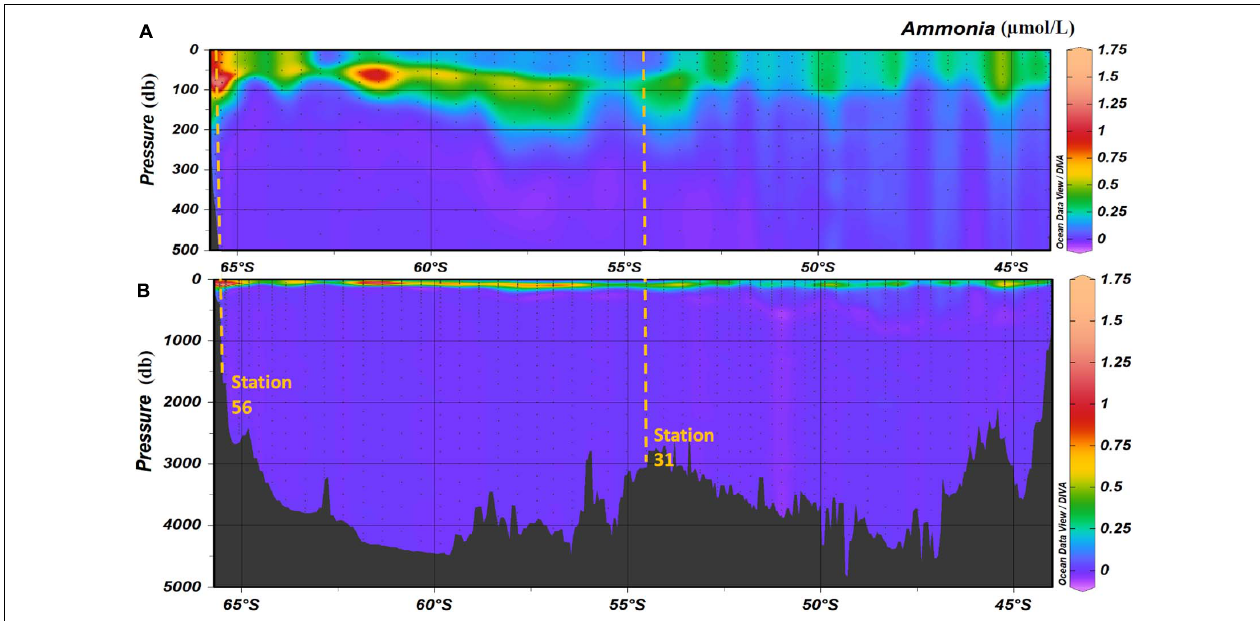
FIGURE 5 | Ammonia concentration (in µ mol/L) in the water column during along the SR03 transect (voyage 1). Panel (A) represents the top 500 m and panel (B) represents the entire water column. Stations 31 and 56 are highlighted with the orange dashed lines. Pressure is in decibar (db). Data were plotted using the Ocean Data View Software (Schlitzer, Reiner, Ocean Data View, https://odv.awi.de, 2020).